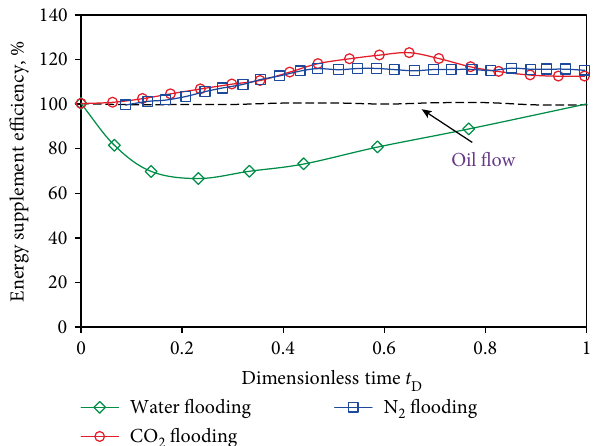
and N flooding. 2 2